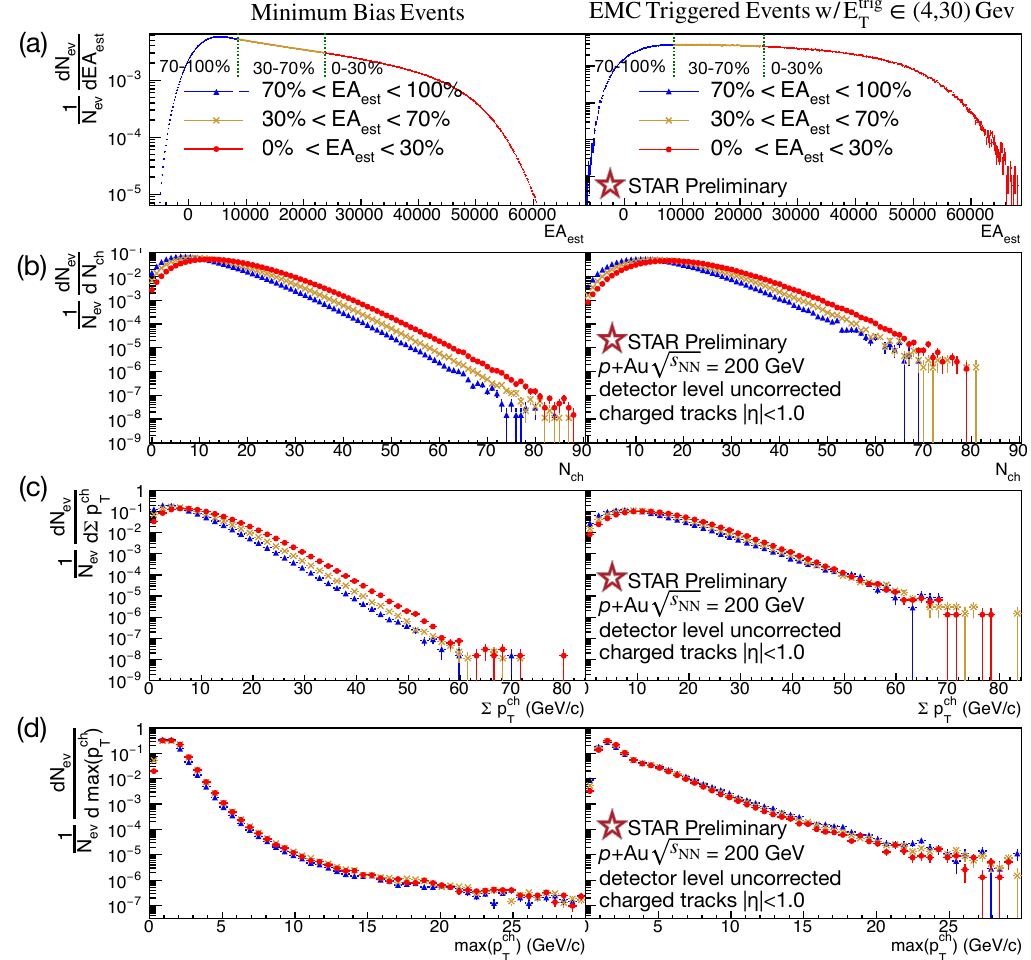
Figure 1. Correlations between charged tracks at STAR ( | η | < 1) and EA est , the Au-going BBC inner ring signal ( | η | ∈ ( 3.3,5.8 ) ). ( a ) left: EA est distribution of MB events, binned for the maximum and minimum 30% as well as the middle 40% of events. ( a ) right: distribution of EA est in for EMC triggered events; the binning boundaries and labels are determined by the MB distribution. Columns ( b ), ( c ), and ( d ) give the distributions for the low, mid, and high EA est bins for charged track multiplicity, summed p T , and maximum p T